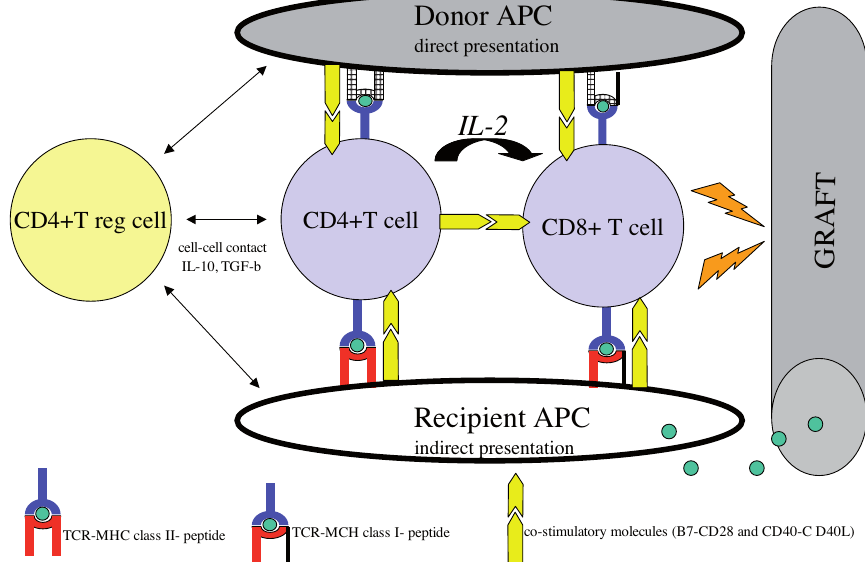
Immune response against a transplanted organ. The alloimmune response against the transplanted organ is activated by two path- ways. With the direct pathway, the donor anti- gen presenting cell (APC) transplanted with the graft presents donor antigen (HLA molecules or minor antigen) to the CD4 + and CD8 + T cells which are activated in the secondary lymphoid organ. Recipient APCs migrate to the graft, process donor Ag and activate CD4 + and CD8 + T cells, which recognise the alloantigen pre- sented by the self-APC in the secondary lym- phoid organ. Activation is mediated by the TCR (in blue) which recognises the HLA (in red) and peptide (in green) in the presence of co-stimu- lation (yellow) such as B7 (APC)-CD28 (T cell) and CD 40 (APC)-CD40 ligand (T cell). The pres- ence of IL-2 is required. By a mechanism that is still unclear (cell-cell contact or inhibition by cytokines such as TGF- b or IL-10), regulatory cells such as CD4 + CD25 + are able to suppress CD4 + and CD8 + T-cell